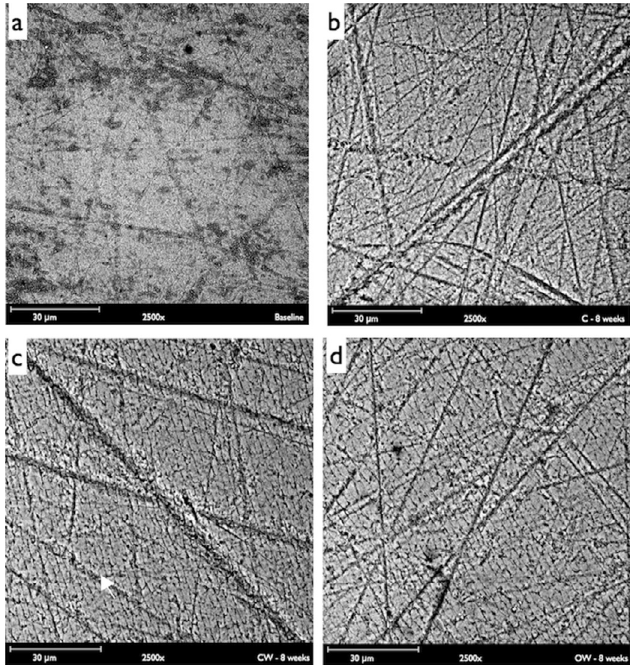
Figure 4- Representative scanning electron microscopy (SEM) micrographs of enamel before (a) and after eight weeks of CSTC: Colgate (b), Colgate Luminous White – CW (c) and Oral B 3D White – OW